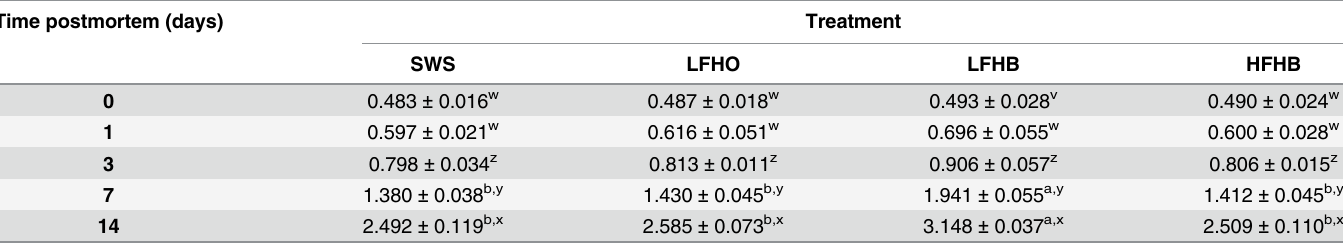
SWS: slaughter without stunning, LFHO: low frequency head-only, electrical stunning, LFHB: low frequency head-to-back electrical stunning, HFHB: high frequency head-to-back electrical stunning. a,b means within the same row with different superscripts are signi fi cantly different (p < 0.05).